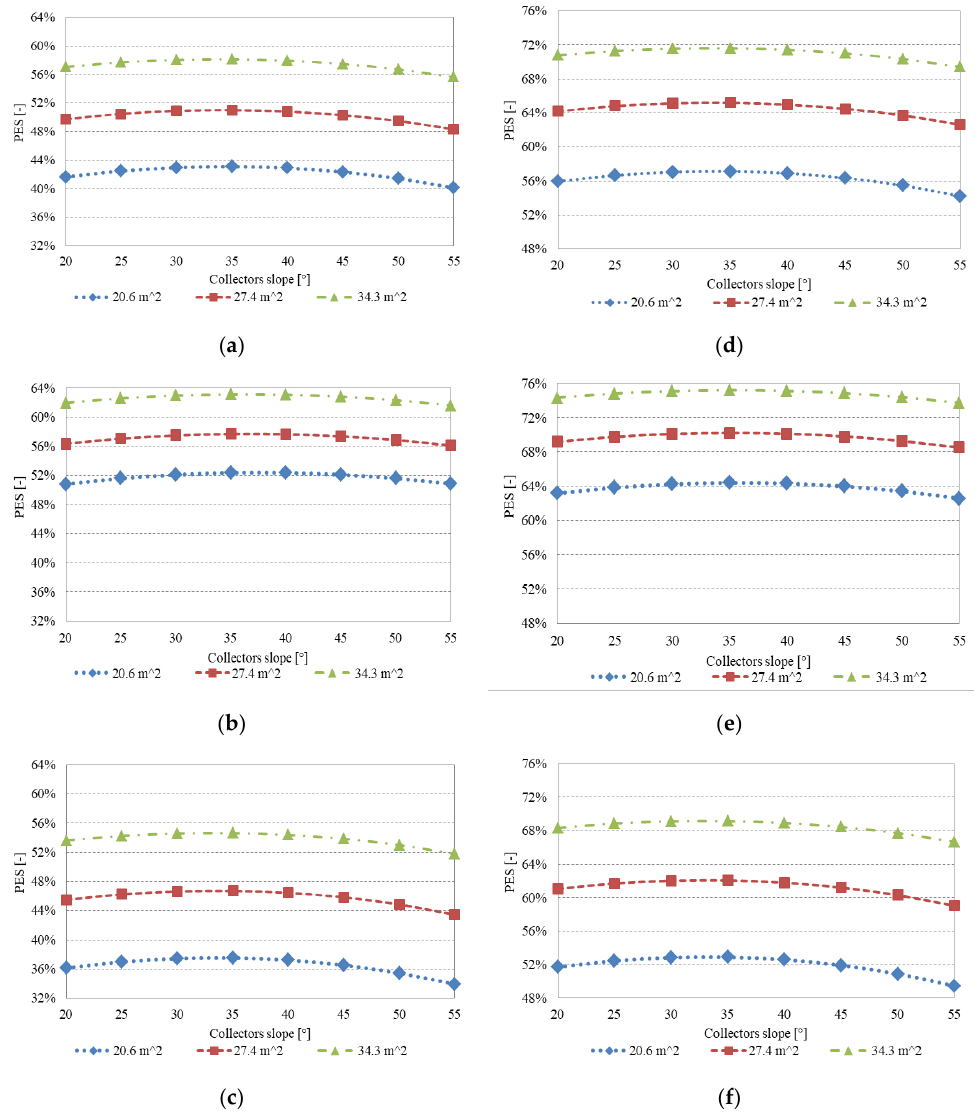
Figure 8. Primary energy savings as a function of the tilt angle and the solar field aperture area when half of the solar thermal energy surplus is used (left side) and when it is totally used (right side) for: ( a , d ) silica-gel DW, ( b , e ) MILGO DW and ( c , f ) zeolite-rich tuff DW.